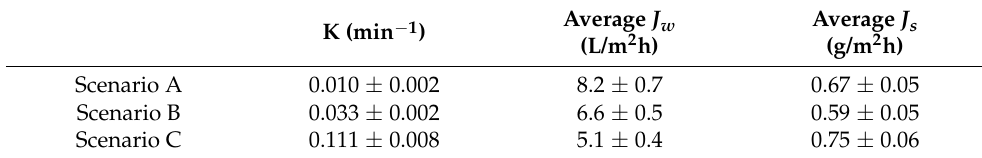
Table 2. Kinetic fouling